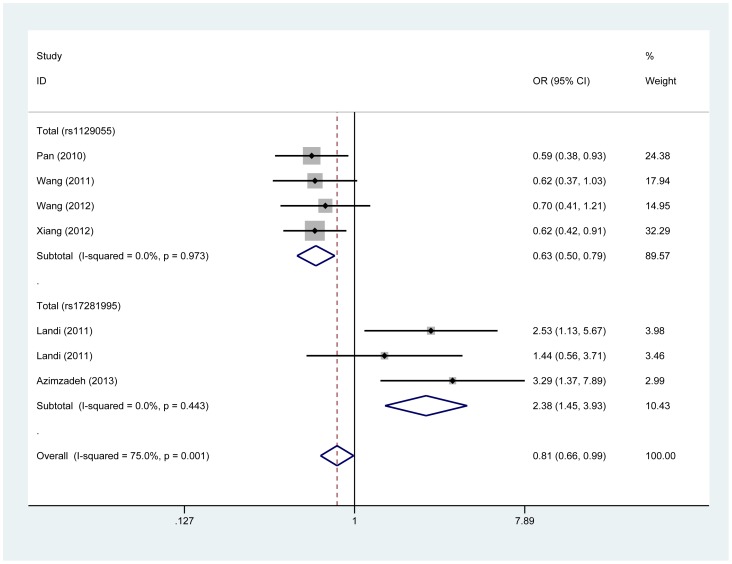
Forest plot of estimates of the odds ratios (ORs) for CD86 polymorphisms in cancer under GG versus GA+AA for rs1129055 and CC versus GC+GG for rs17281995.The squares and horizontal lines correspond to ORs and 95% CIs of specific study, and the area of squares reflects study weight (inverse of the variance). The diamond represents the pooled ORs and its 95% CIs.